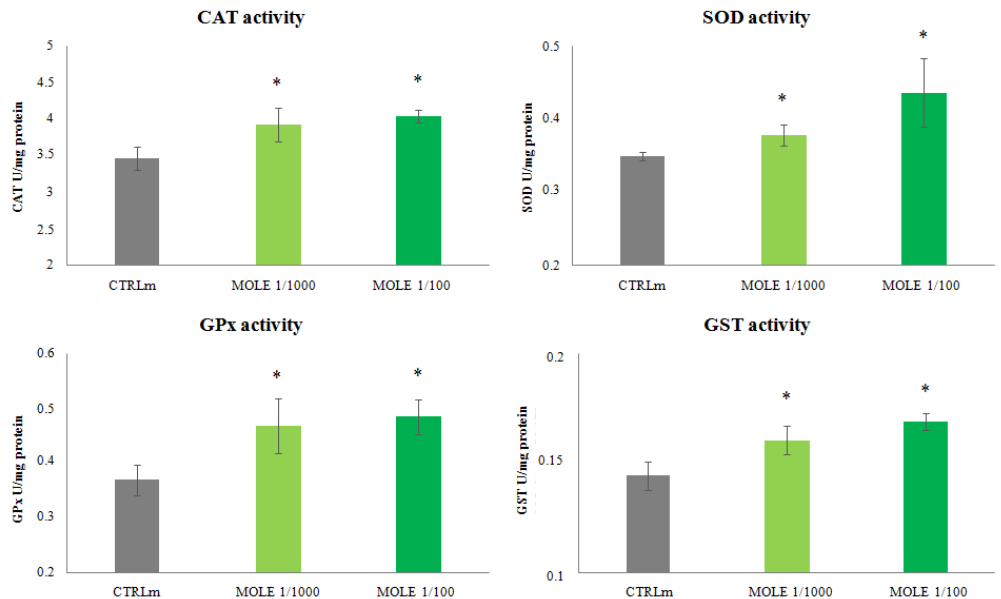
Figure 5. Catalase, superoxide dismutase, glutathione peroxidase and glutathione transferase activities analysis. Measure- ment of CAT, SOD, GPx and GST analysis was performed in C2C12 myotubes after 24 h MOLE (1/1000 and 1/100 working solutions) treatments. Data presented are the mean ± SD of three experiments. * p < 0.05 vs.